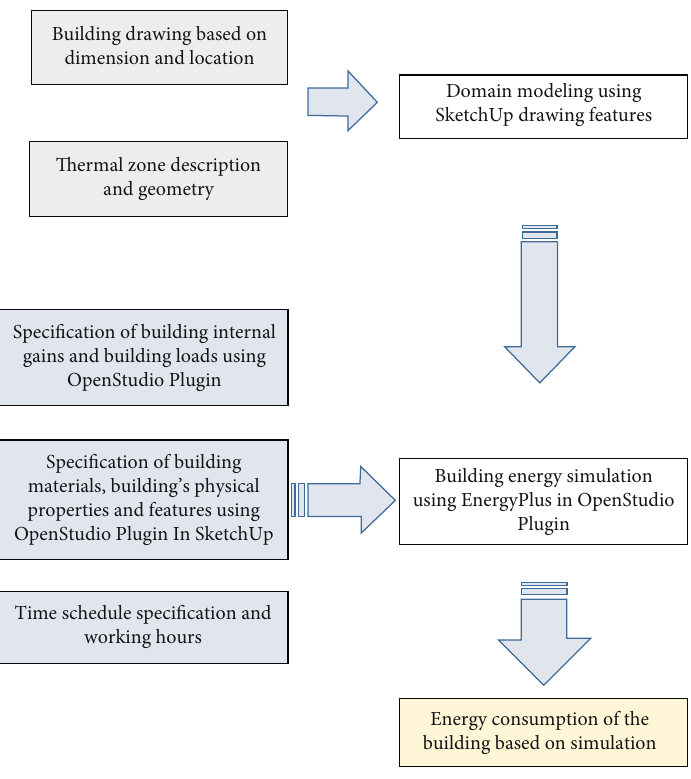
Figure 2: Neural network model